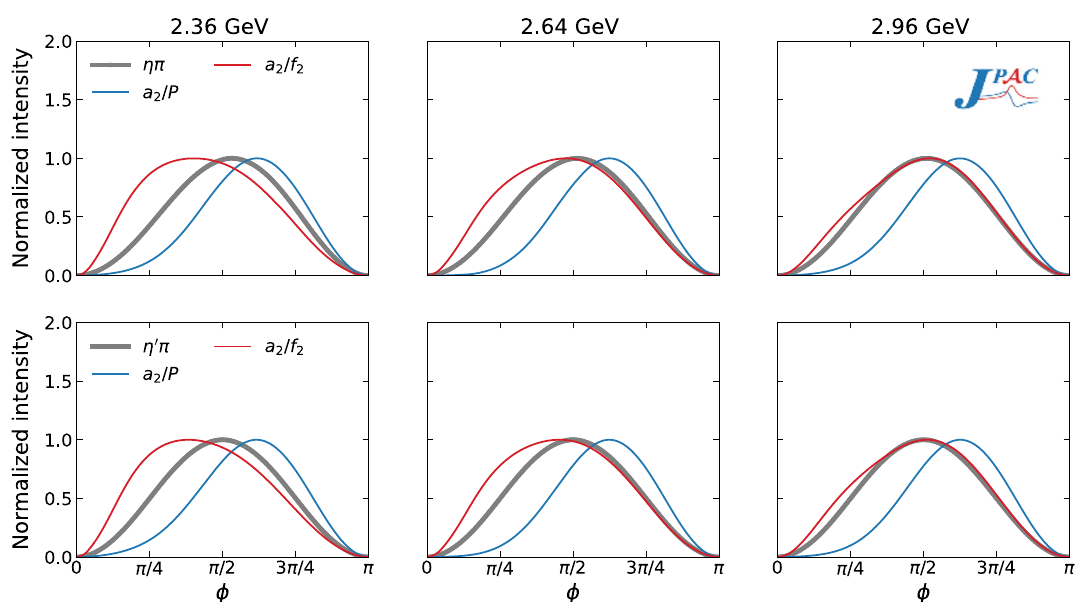
Fig. 9 Intensity distribution of φ from MVR (grey), for three fixed energies and cos θ = 0 . 866 (close to the forward peak) for ηπ (upper row) and η (cid:2) π (lower row) compared to the same distributions for the